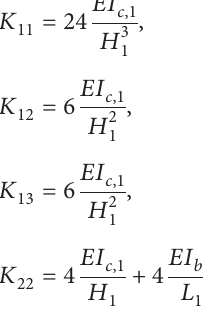
sponds to the force at the i -th degree of freedom when a unitary acceleration is assigned at the same degree of freedom is